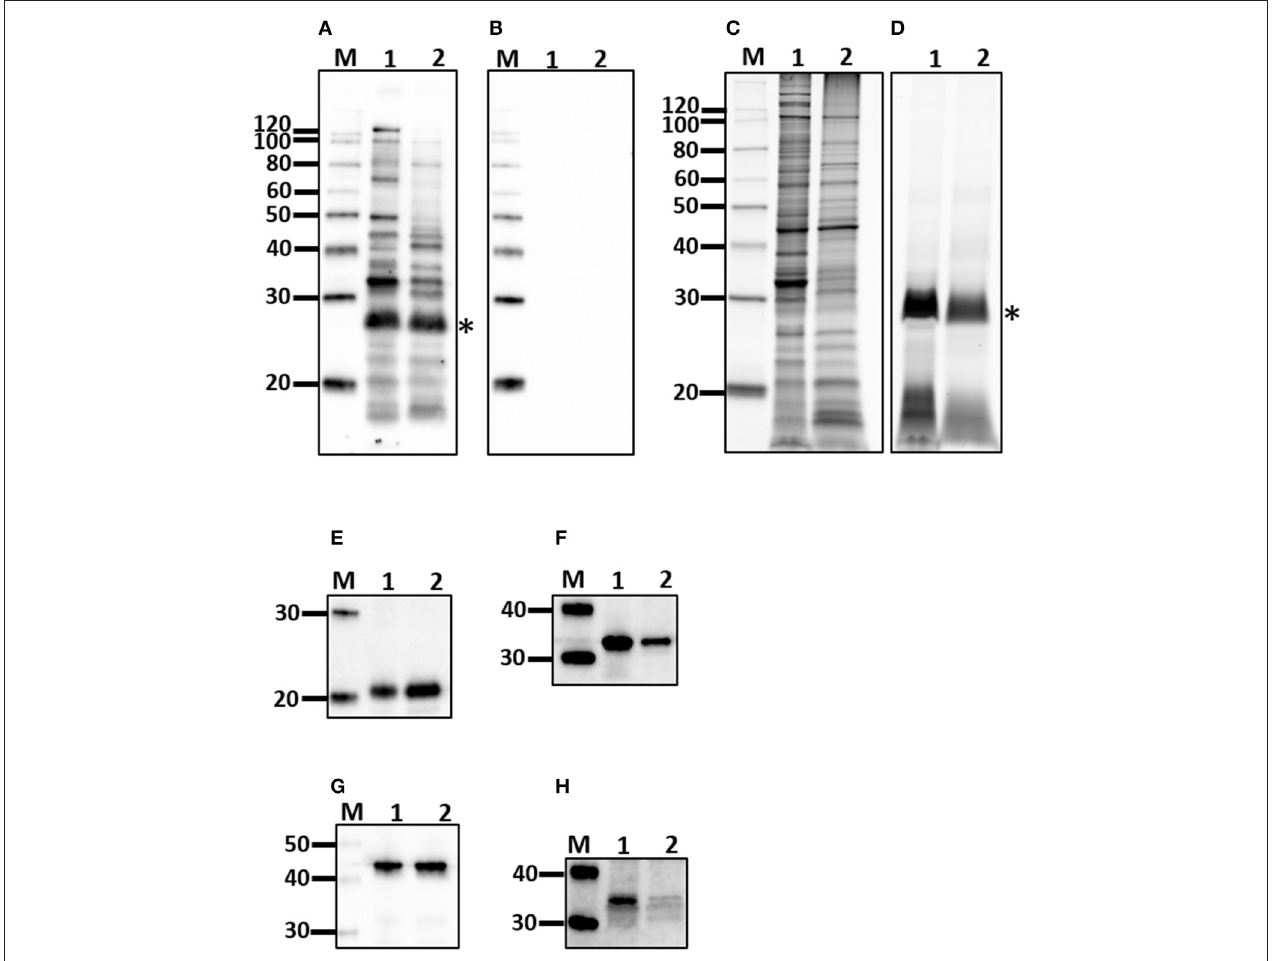
FIGURE 2 | Characterization of outer membrane (OM) fraction. Antigen derived from whole cells (1) was compared to the OM fraction (2) by immunoblotting with sera from experimentally infected rats (A) or non-infected controls (B) and for protein (C) , and lipopolysaccharide content (D) , as well as the presence of LipL21 (E) , LipL32 (F) , LipL41 (G) , and FlaA (H) . *Indicates O-antigen. Molecular mass markers (M) are